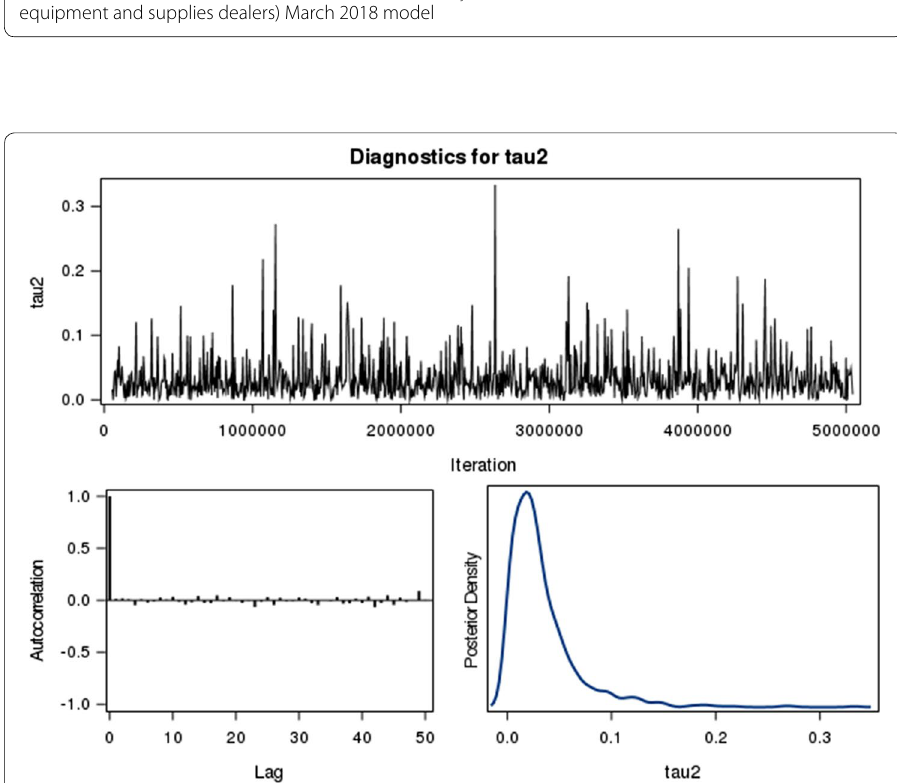
Fig. 5 MCMC diagnostics for τ 2 (variance of the random effect) in the NAICS 444 (building material